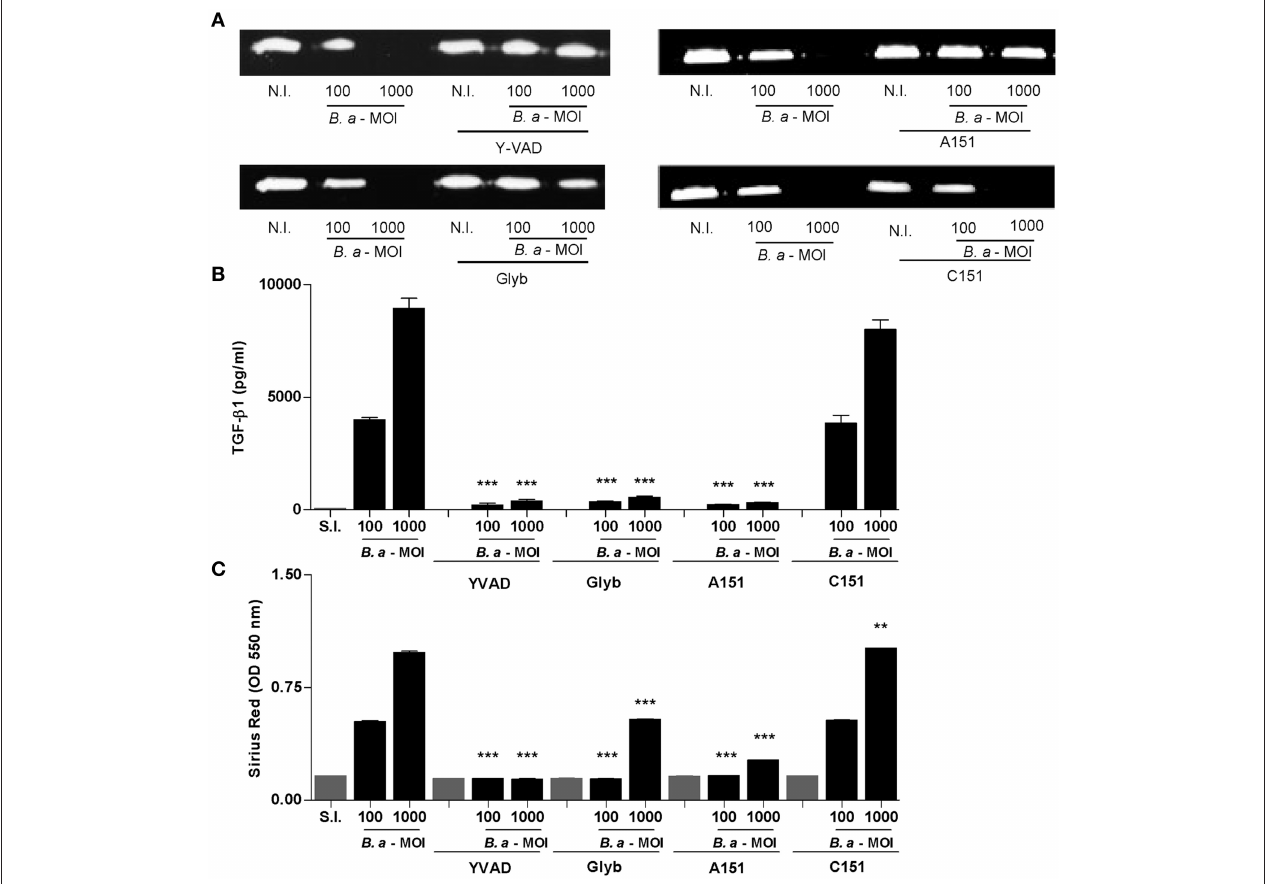
FIGURE 5 | Inflammasome is involved in profibrogienic response of LX-2 cells. LX-2 cells were infected with B. abortus at MOI of 100 and 1000 in the presence or not of Z-VAD-FMK (ZVAD), Y-VAD-FMK (YVAD), Bay 11-7082 (Bay), and glybenclamide (Glyb). At 24h after infection, supernatants were harvested to analyze MMP-9 production by zymography (A) and TGF- β 1 secretion by ELISA (B) . Quantification of collagen deposition was revealed by Sirius red staining by OD readings at 550nm at 10 days post-infection (C) . Data are given as the means ± SD of duplicates. ** P < 0.01; *** P < 0.001 vs. non-infected cells (N.I.).